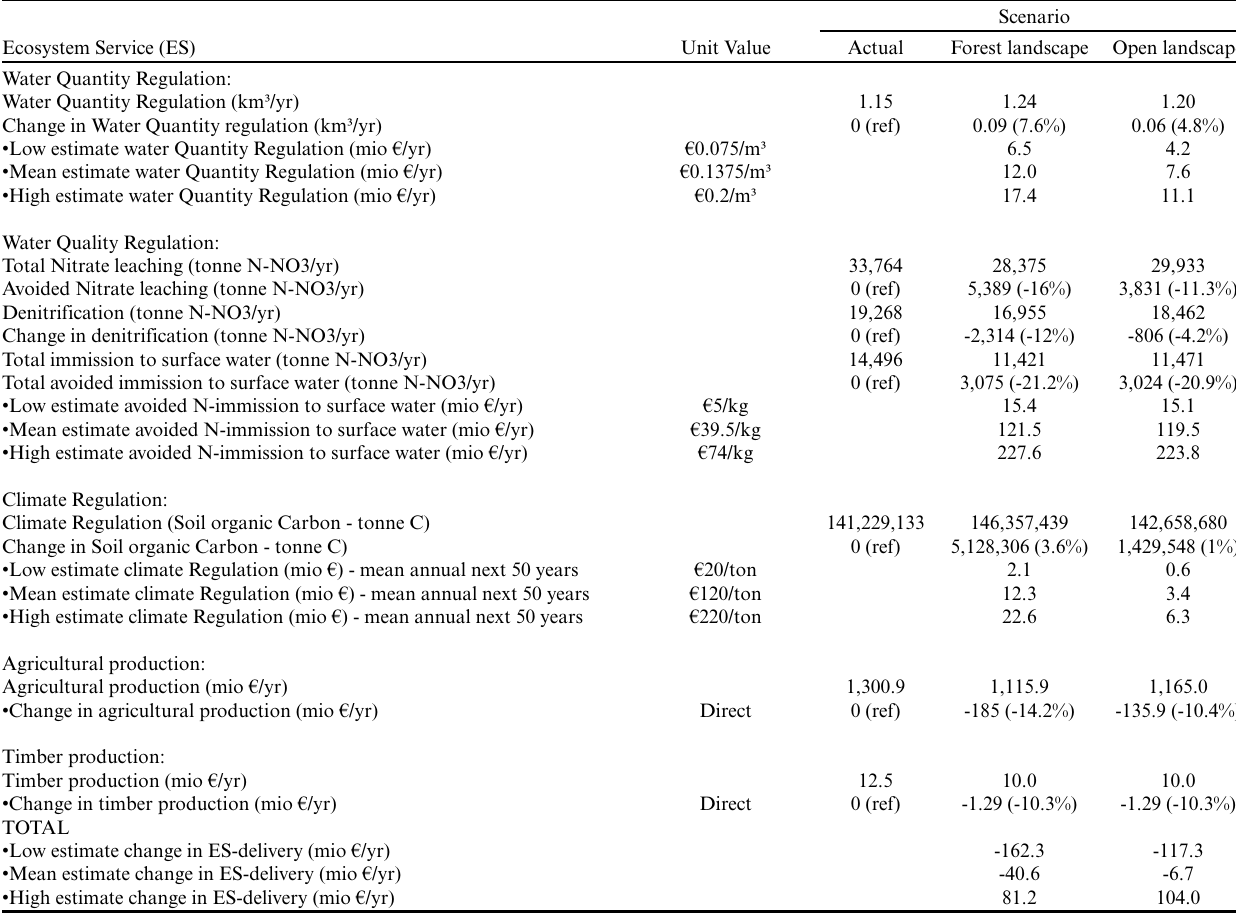
Table 4. Absolute losses and gains in biophysical and monetary terms for the current situation compared to a forested and open landscape wetland restoration